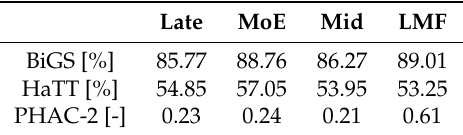
Table 7. Results obtained for models trained on datasets containing noised/zeroed inputs from the leading modality and a zeroed leading modality during